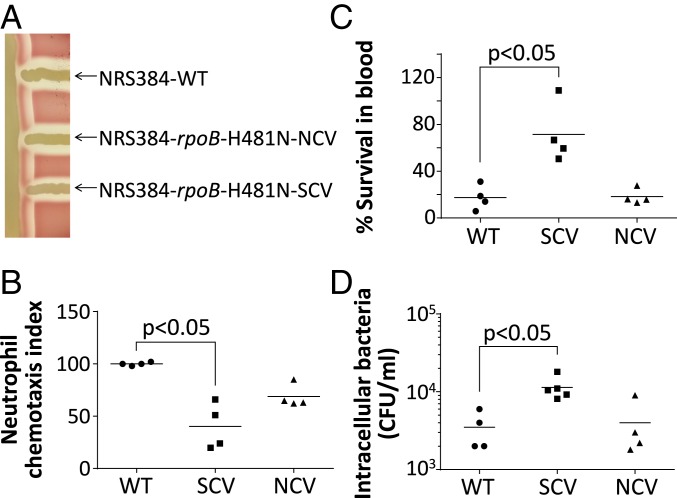
Phenotypic characterization of the S. aureus SCV. (A) Hemolysin activity of S. aureus NRS384 WT, NRS384-rpoB-H481N-NCV, and NRS384-rpoB-H481N-SCV. Reduction in delta-hemolysin activity in the SCV is visible by reduced hemolysis at the intersection with the vertical streak of NRS384-ΔΦSa3. Reduction in alpha-hemolysis of the SCV is visible at the top and bottom of the SCV streak. (B) Whole human blood killing assay. The SCV is significantly less susceptible to killing by whole human blood. (C) Human neutrophil chemotaxis assay. The SCV shows significantly reduced neutrophil chemotaxis relative to the WT. (D) Host cell invasion assay. Significantly more intracellular SCV was recovered 2 h after infection of A549 adenocarcinoma human alveolar basal epithelial cells. All experiments were performed in at least quadruplicate and horizontal bars represent the mean. A 2-tailed Mann–Whitney U test with P < 0.05 was used to infer statistical significance. CFU, colony-forming unit.